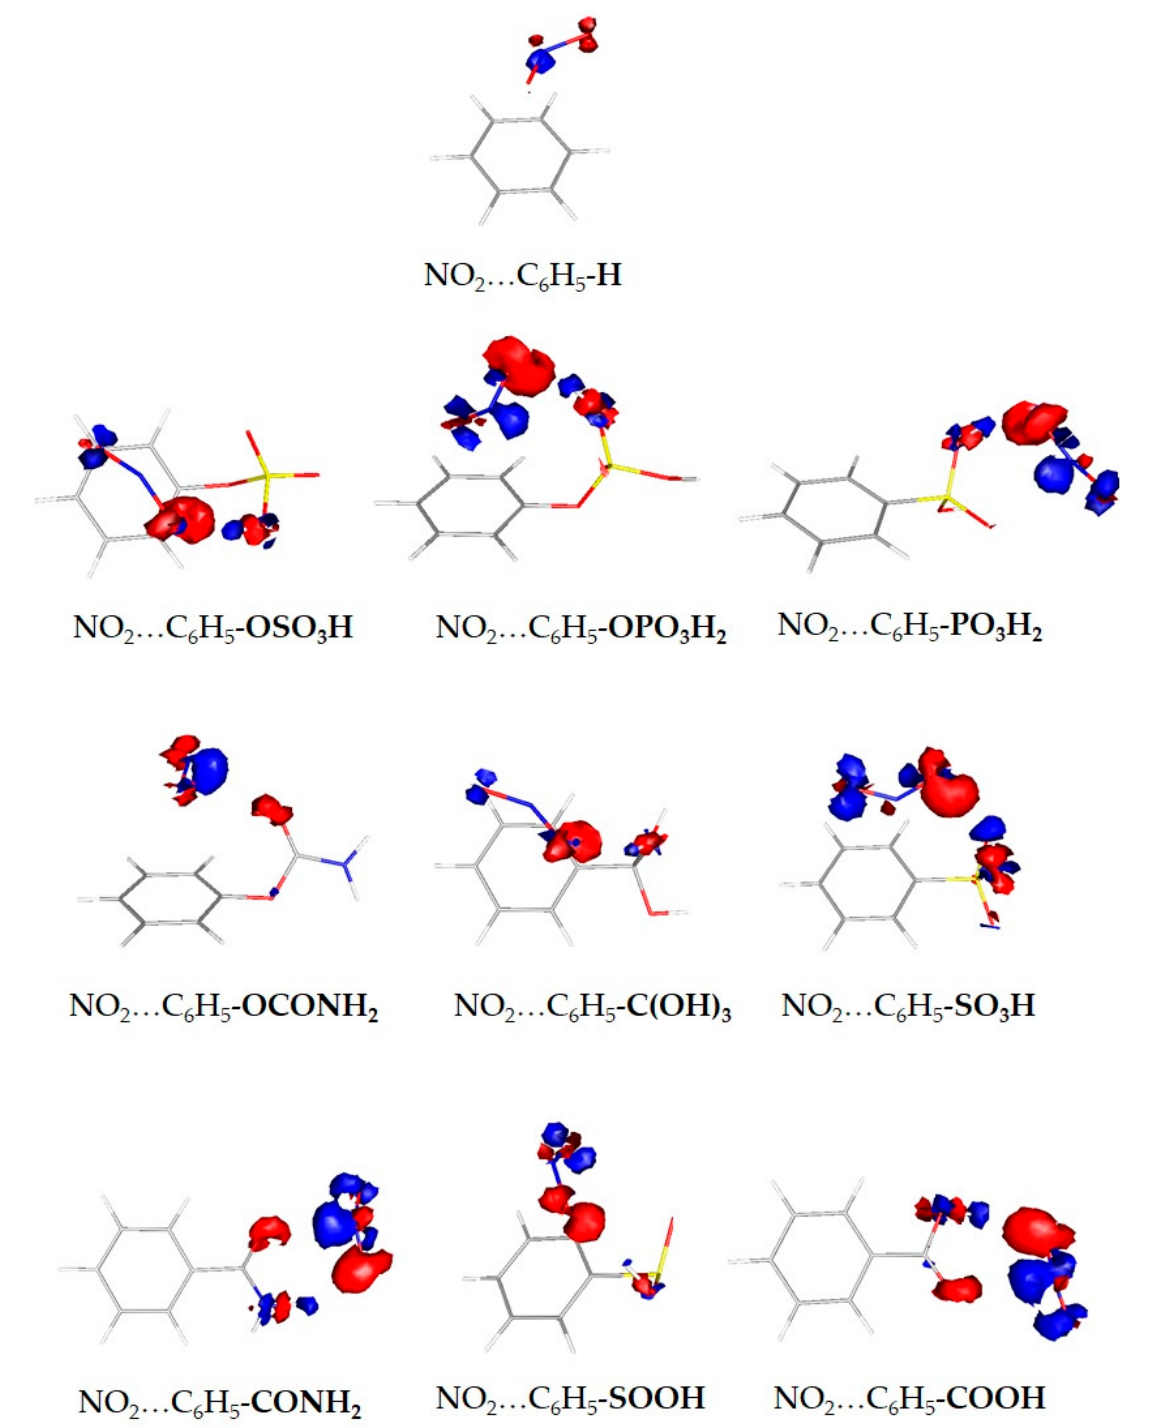
Figure 3. Electron density redistribution plots of the optimized geometries of the NO 2 . . . C 6 H 5 -X complexes. With red and blue the regions that gain and lose electron density upon the formation of the complex, respectively.